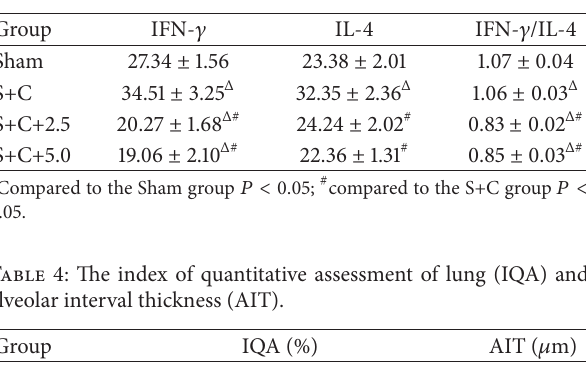
Table 3: Effects of DEX administration on IFN- 𝛾 , IL-4, and IFN- 𝛾 /IL-4 mRNA expression during postpartum BMODS in rats.